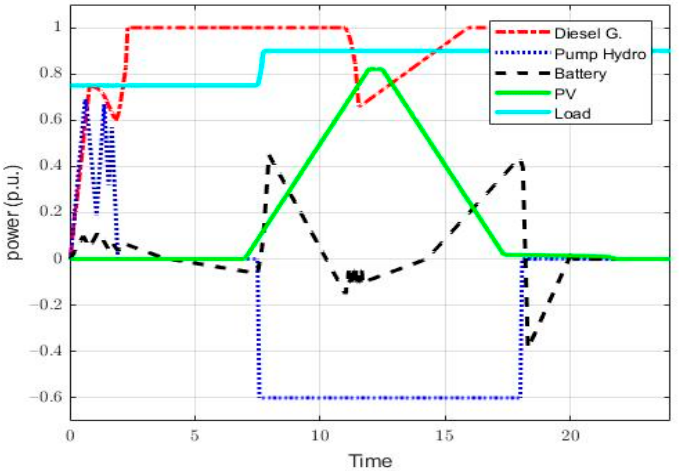
Figure 11. Power response of the microgrid with storage system without full-day wind power.